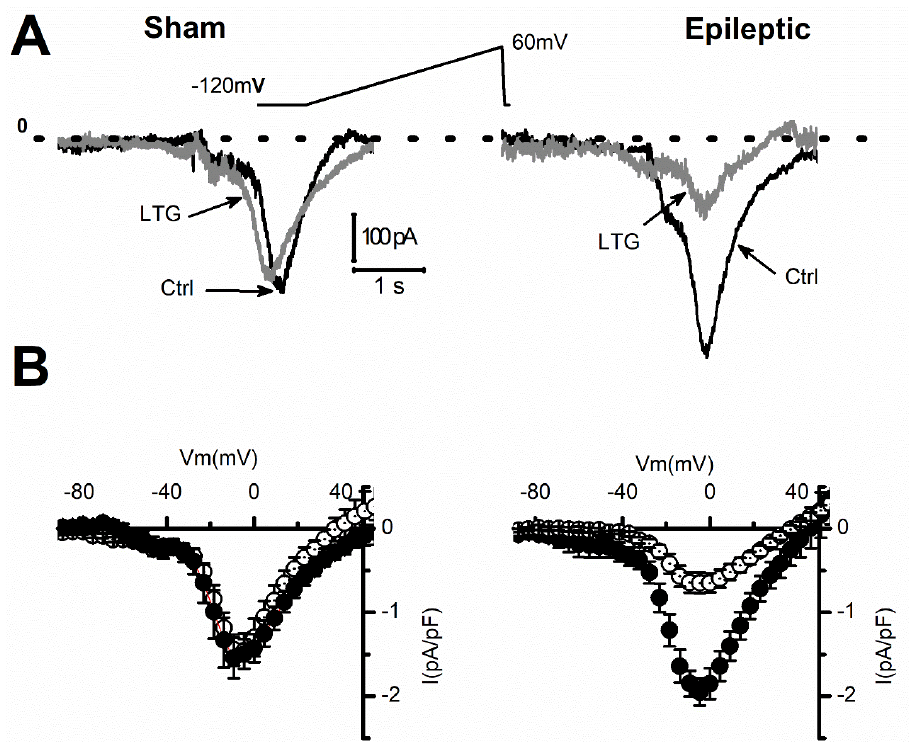
Figure 6. LTG blocked I NaL current in cardiomyocytes from epileptic animals but had no effect in sham rats. ( A ) Representative I NaL recordings from sham and epileptic rat cardiomyocytes in control conditions (ctrl, black) and in presence of 10 µmol/L/L of Lamotrigine (LTG, gray). Currents were elicited by a voltage ramp protocol from −120 to 60 mV with a 0.04 mV/ms rate. ( B ) IV-curves showing the average of current density values for sham (left) and epileptic animals (right) in control conditions (filled circles) and to 10 µmol/L/L of LTG (empty circles). Number of animals: 3/group (ctrl and LTG). Number of cells: Sham (ctrl, LTG):12, 12; Epileptic (ctrl, LTG): 14, 16.